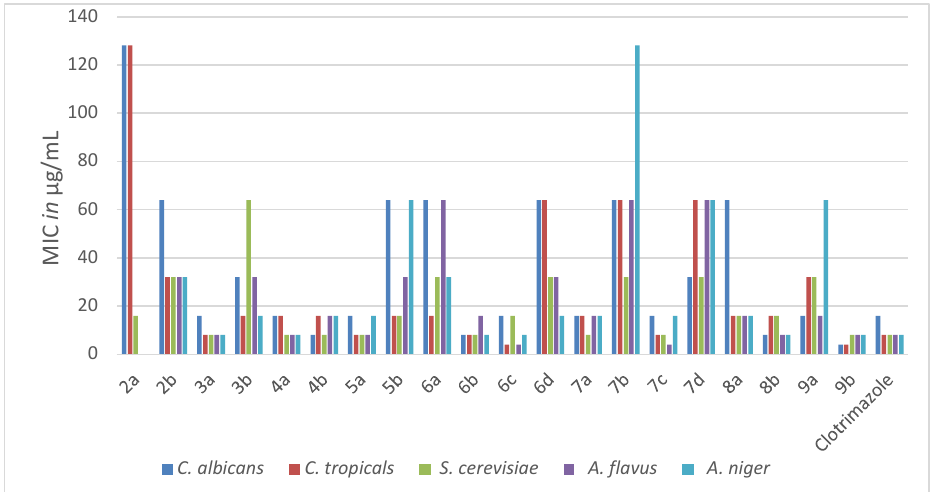
Figure 3. The antifungal activities (MIC in µg/mL) of the new pyridothienpyrimidine compounds 2a,b–9a,b and the reference drug (clotrimazole).